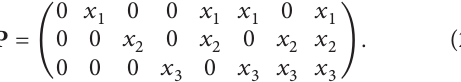
is turned on. These measurements are denoted by 𝑇𝑚 𝑗 (𝑛) (as illustrated by the black curve in Figure 4), 𝑖 where 1 ⩽ 𝑖 ⩽ 𝑀 denotes the 𝑖 th node and 1 ⩽ 𝑗 ⩽ 2 𝐾 is the 𝑗 th combination of HVACs turned on or off.